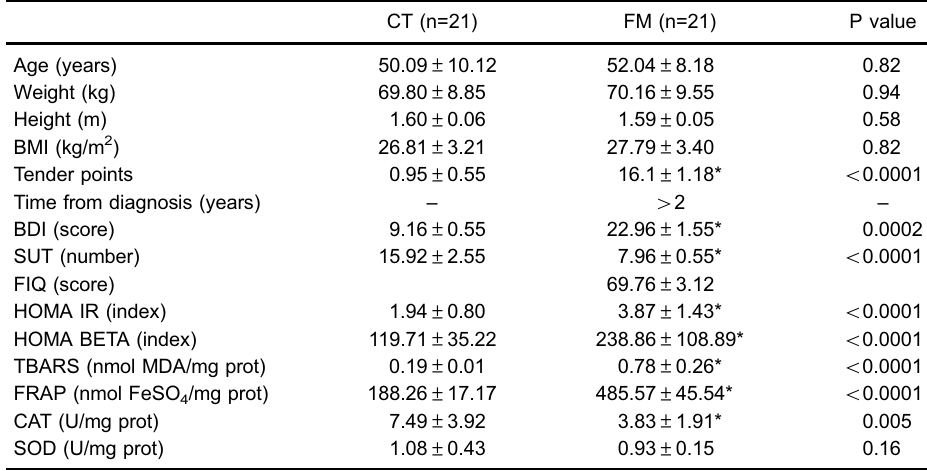
Table 1. Characteristics of study